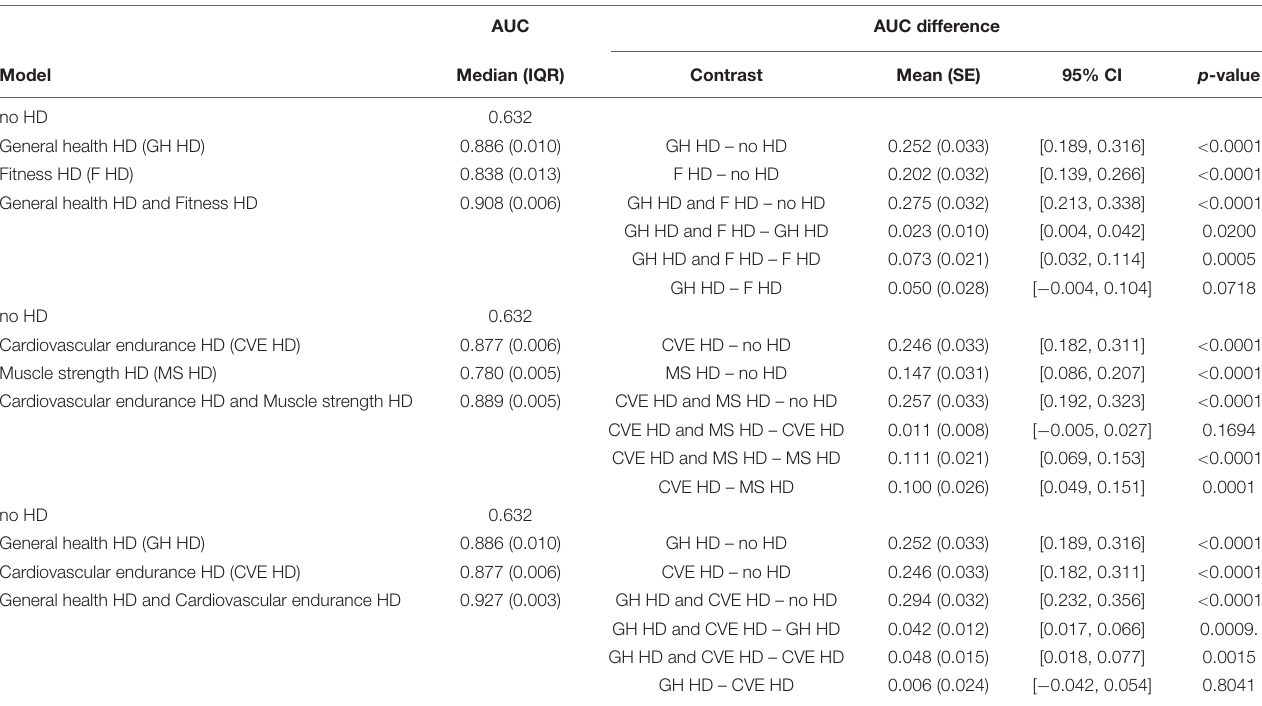
TABLE 5 | Areas under receiver operating characteristics curves (AUC) in models with different health distances (HD) as predictors of Heart Failure. AUC presented as median (IQR) across all imputed